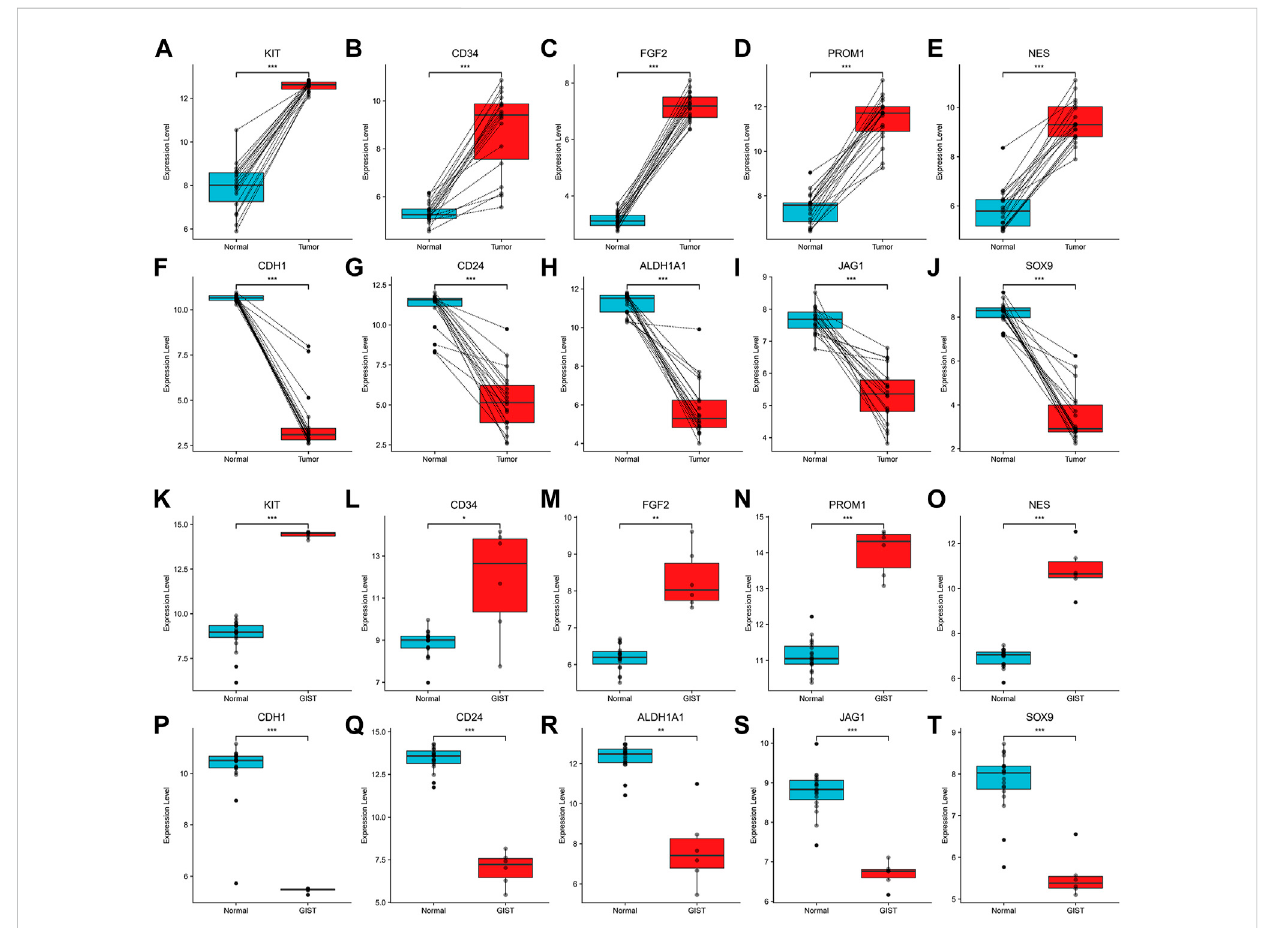
FIGURE 8 Expression of hub genes. (A – J) . Expression of KIT, CD34, FGF2, PROM1, NES, CDH1, CD24, ALDH1A1, JAG1 and SOX9 in Our cohort and (K – T) GSE13861. * p < 0.05, ** p < 0.01, *** p <